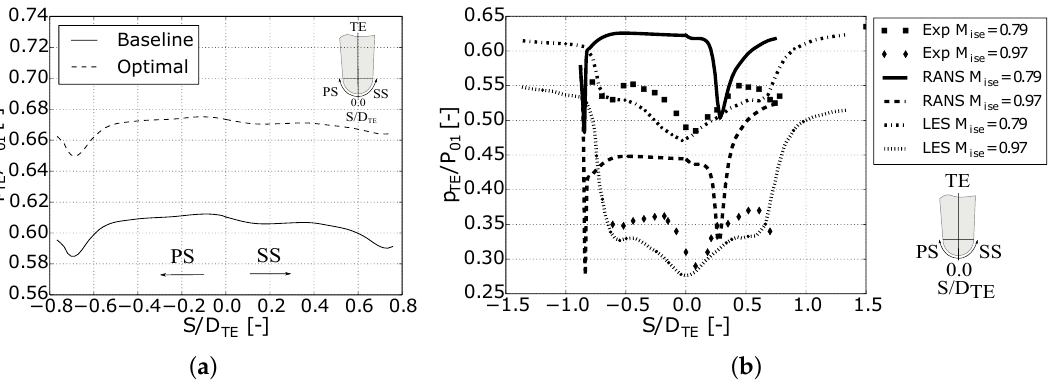
Figure 7. Trailing edge (TE) pressure distributions for the pressure side (SS) and suction side (SS). ( a ) Optimal vs. Baseline trailing edge pressure distributions; ( b ) Trailing edge pressure distribution with the blade tested by [28]. Large eddy simulation (LES) results are from